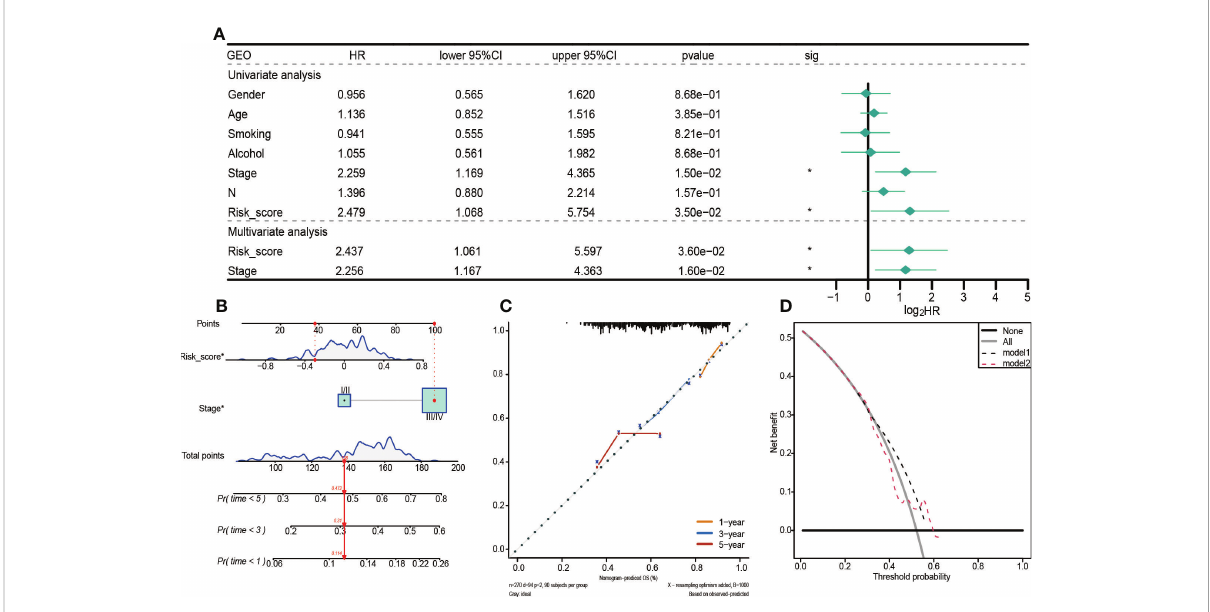
FIGURE 6 Prognostic values of the 5-gene signature model in the GEO set. (A) Univariate and multivariate Cox regression analysis to investigate the independence of risk models among clinicopathological factors. (B) Nomogram for predicting the 1-year, 3-year, and 5-year survival probabilities of HNSCC patients. (C) Calibration curve for assessing the agreement between nomogram predicted and actual survival outcomes. (D) Decision curve analyses of the nomogram based on OS